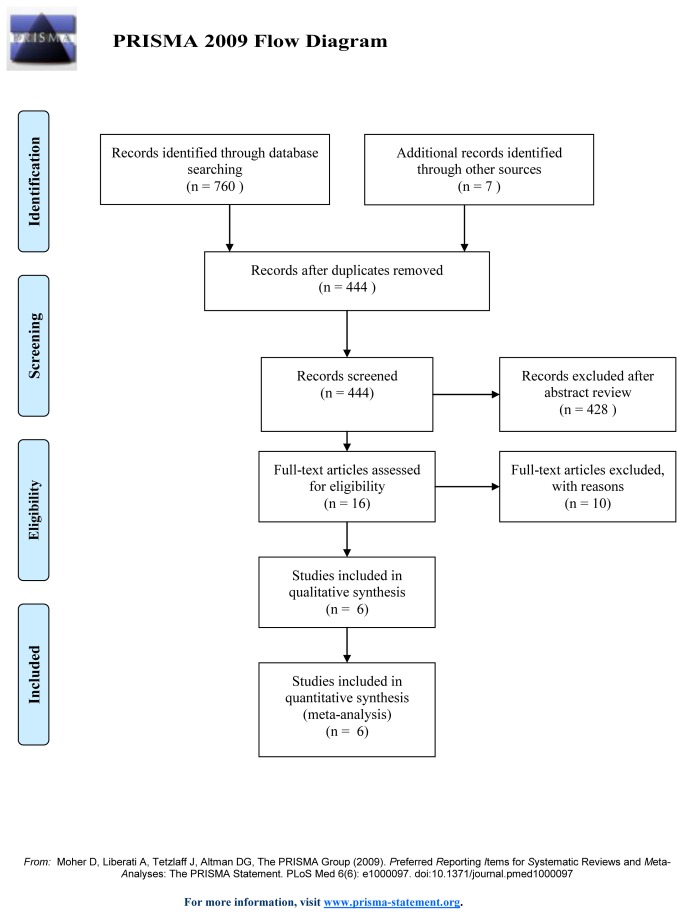
Selection process for randomized controlled trials included in the meta-analysis.